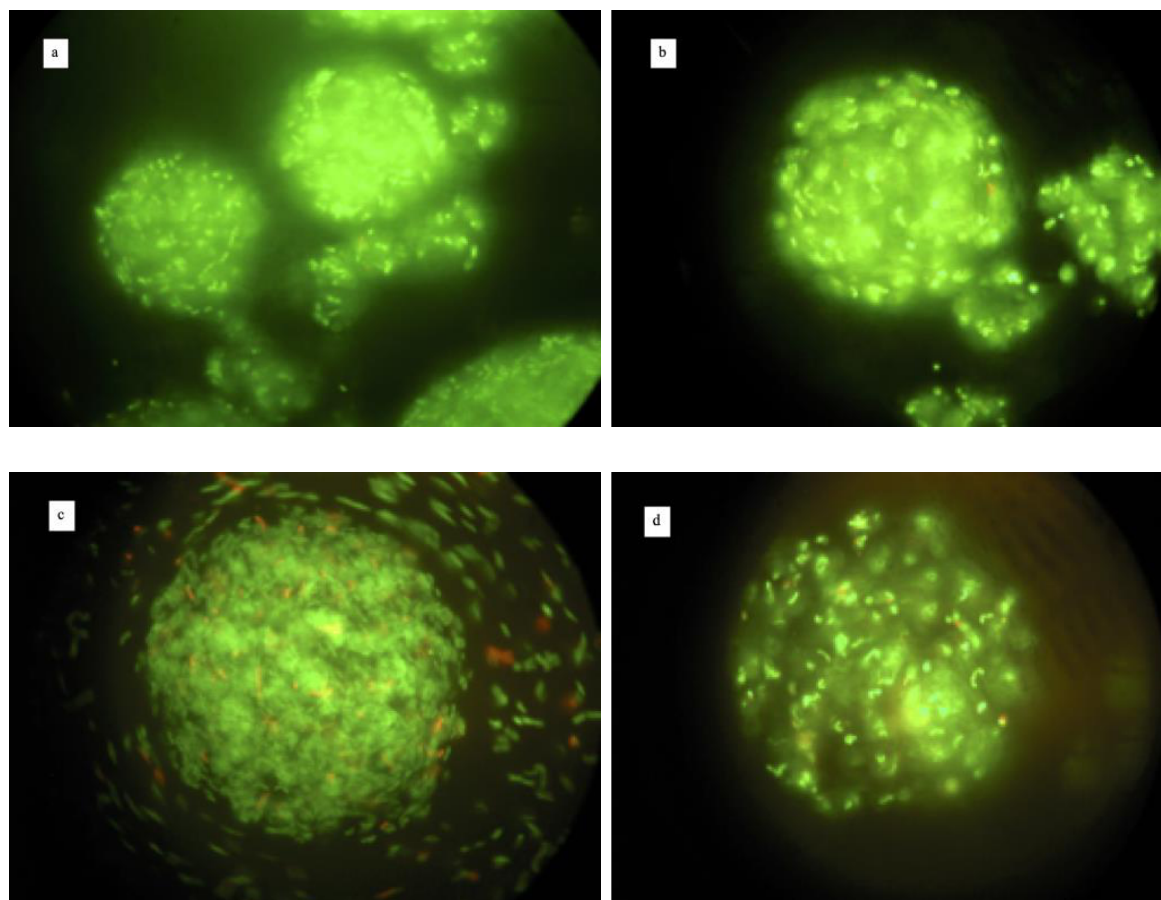
Figure 2. Fluorescence microscopy images at 400 × magnification after viable staining of microencapsules of L. reuteri DSM 17938 (panels a , c ) and L. plantarum 48M (panels b , d ) exposed to gastric (panels a , b ) and intestinal (panels c , d ) conditions.